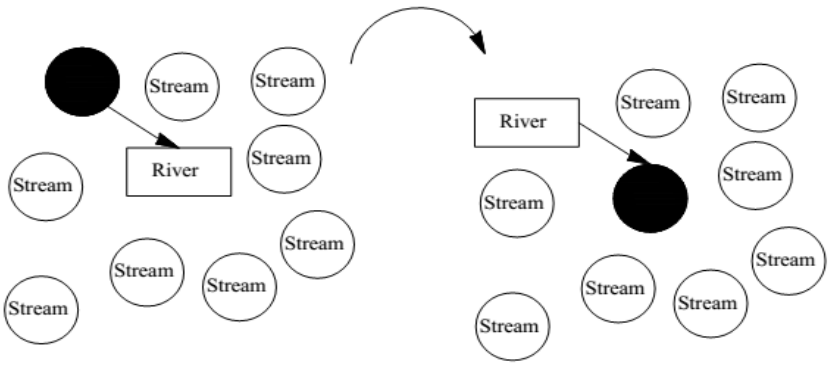
Figure 5. Position exchange between the stream and the river.